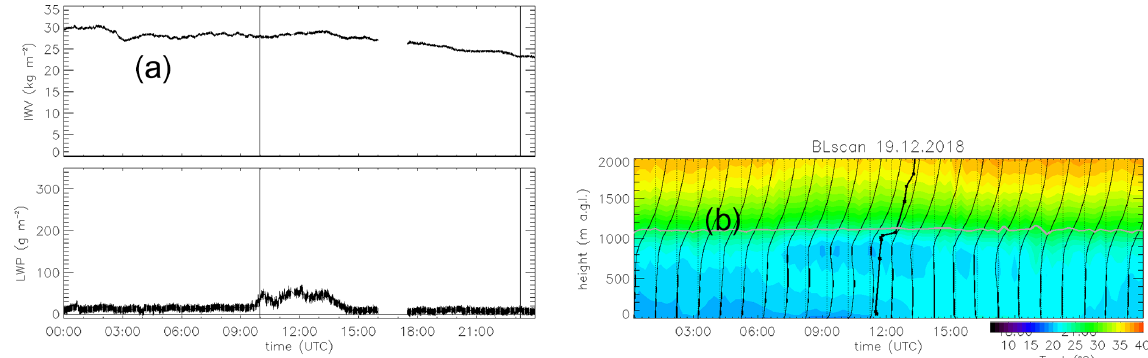
Figure B2. Like Fig. A2 for 19 December 2018.